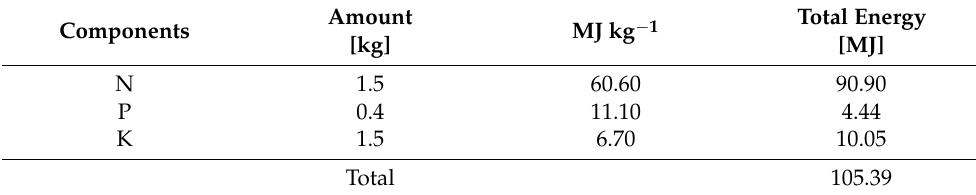
Table 5. The energy equivalent of